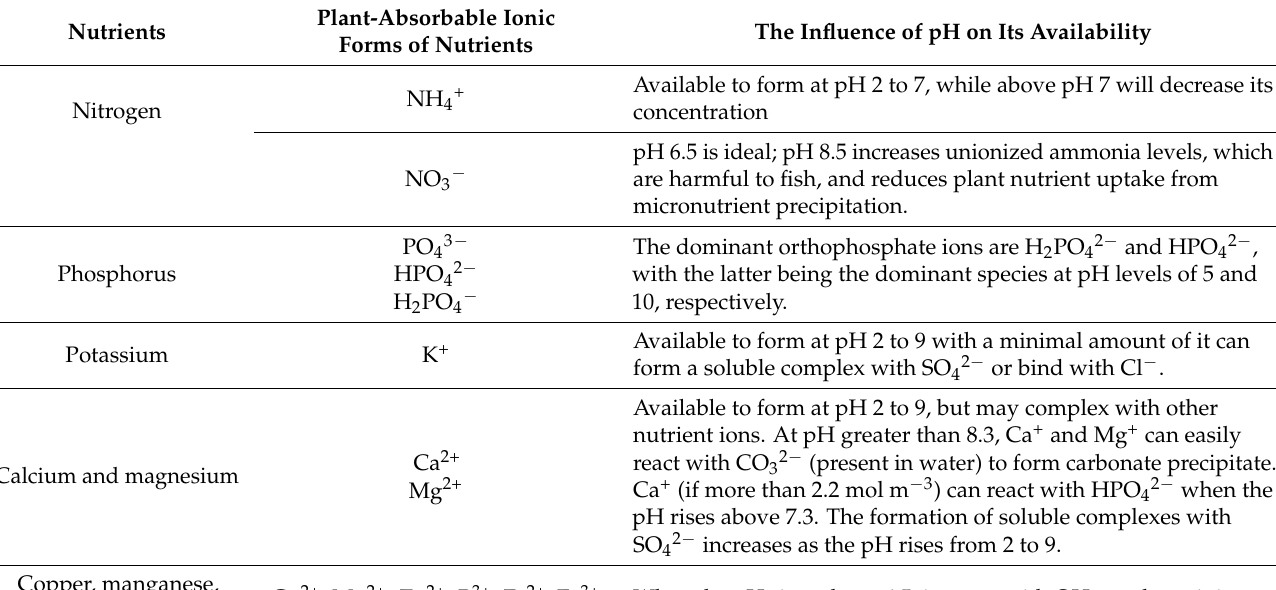
The Influence of pH on Its